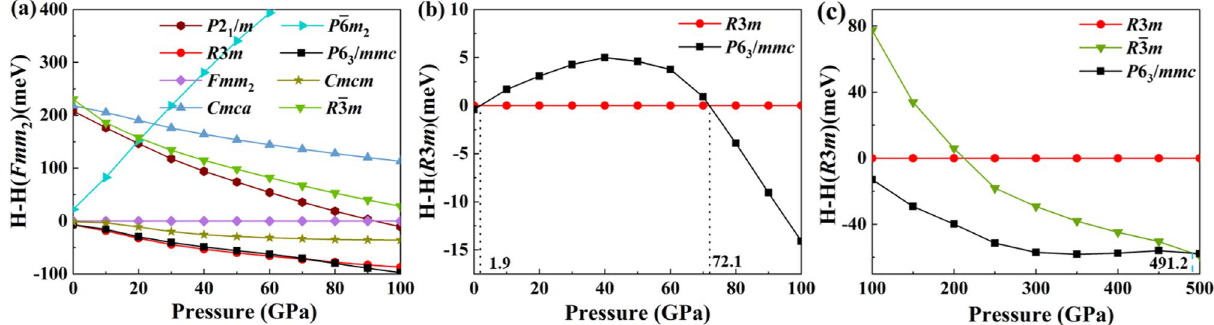
Figure 1. The enthalpy curves of MoSe 2 under high pressure. ( a,b ) MoSe 2 under high pressure with pressure in range of 0 GPa to 100 GPa. ( c ) MoSe 2 under ultrahigh pressure with pressure in range of 100 GPa to 500